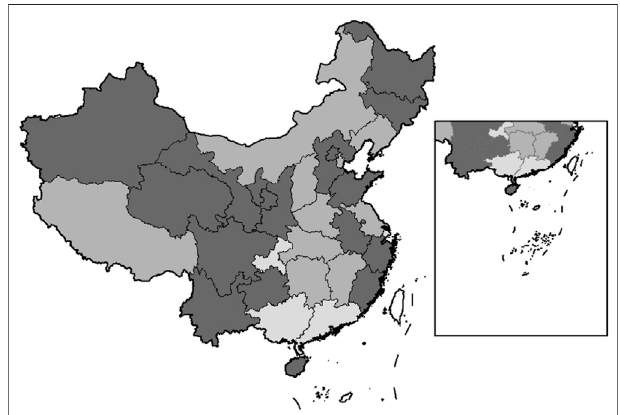
FIGURE 8 | Clustering results of public charging piles shown by